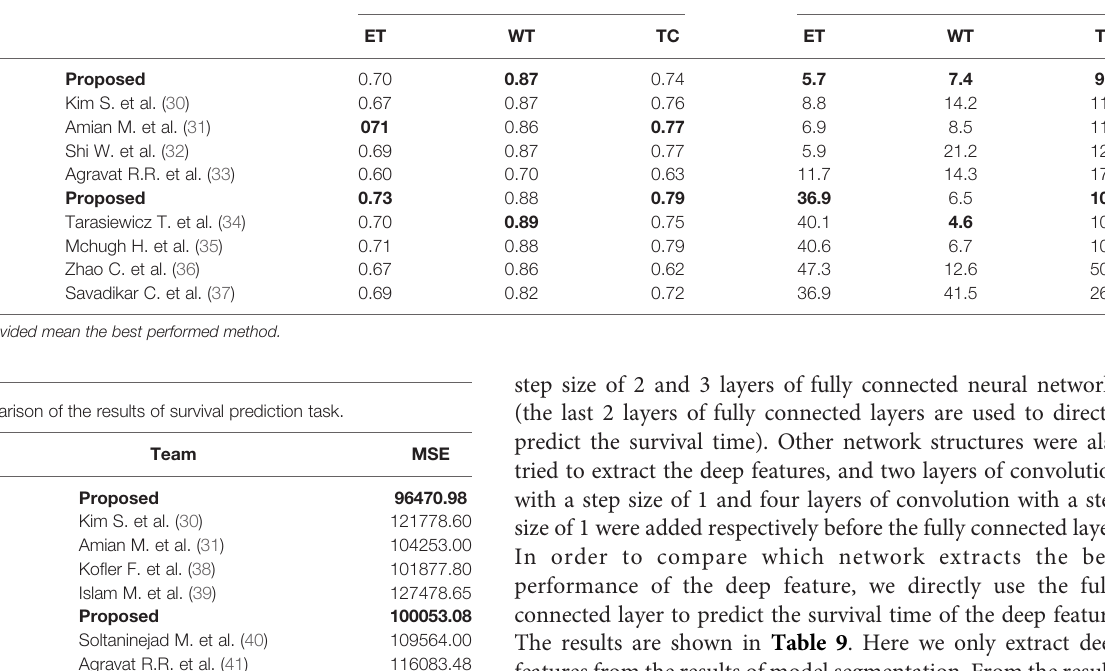
TABLE 7 | Comparison of the results of the segmentation task.